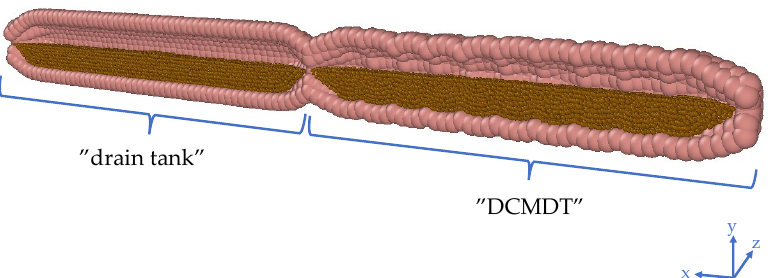
Figure 4. Cross section of the digital twin of the DCM and the ‘drain tank’. The antegrade direction in this image is from the right to the left.